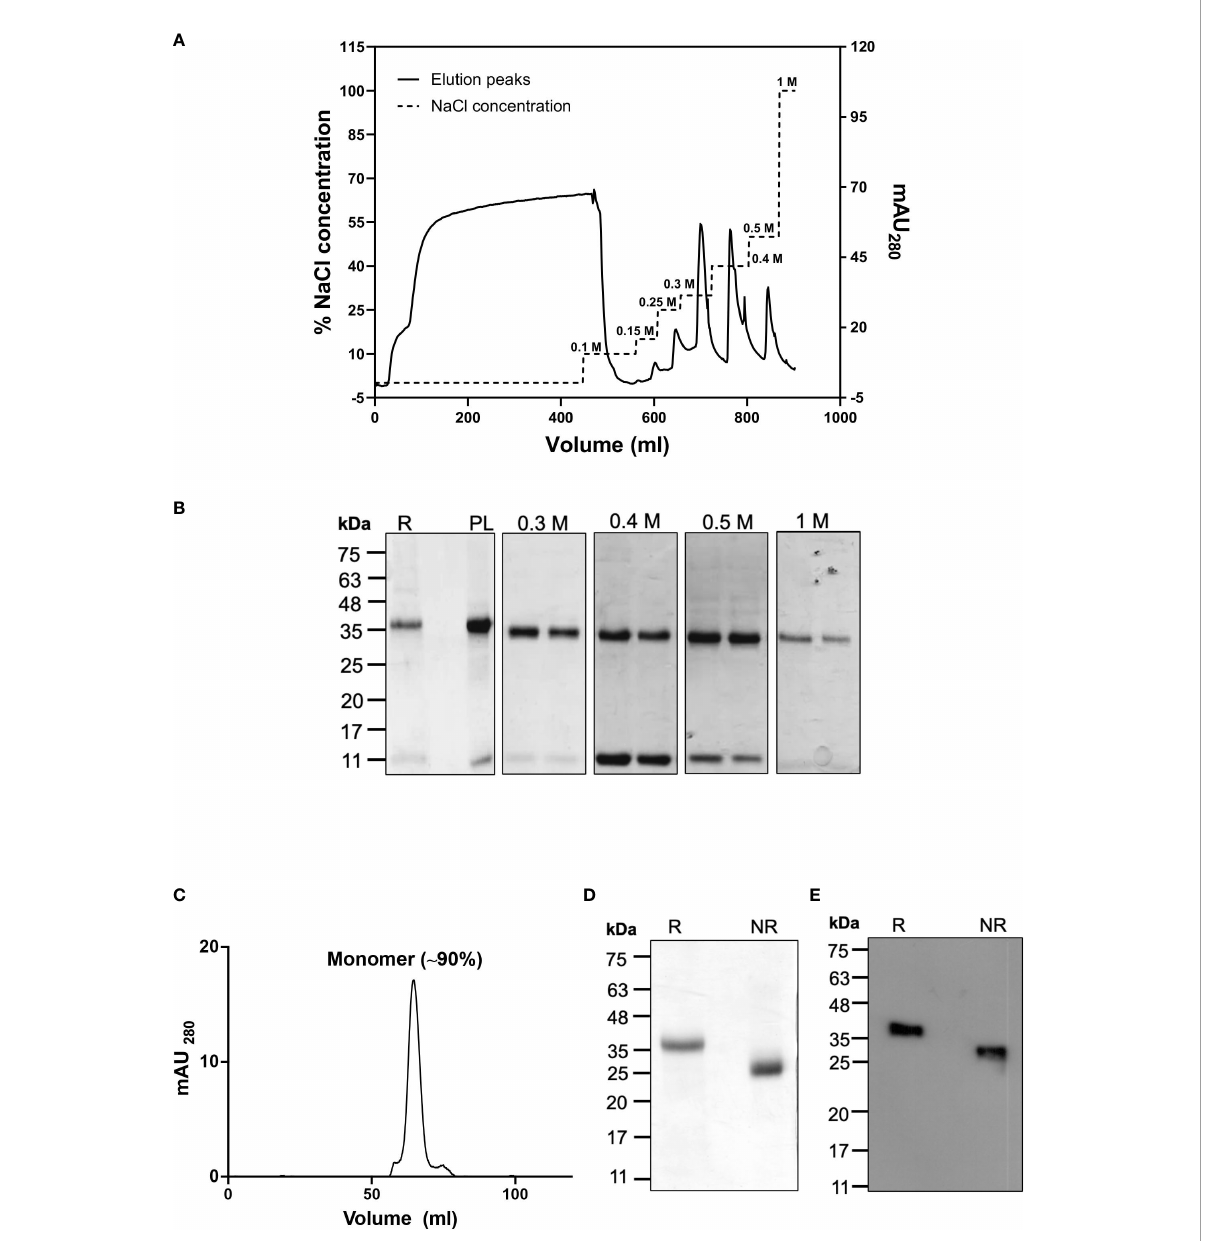
FIGURE 3 Puri fi cation of Tag-free CyRPA by Anion-Exchange Chromatography (A) After refolding, tag-free CyRPA was dialysed and subjected to ion exchange puri fi cation on an AKTA system using anion exchanger Q-sepharose beads. Column was equilibrated with a salt free Tris buffer, then dialyzed CyRPA was loaded onto the column, followed by washing (0.1 M NaCl) and elution (0.15, 0.25, 0.3, 0.4, 0.5 and 1 M NaCl). Solid line indicates elution peaks monitored at 280 nm and dashed lines show percent NaCl concentration used for CyRPA elution with 1 M representing the 100% concentration. (B) Expression of CyRPA after refolding (Refolded [R]), dialysis (dialysed or Preload [PL]) and elution was analyzed in reducing SDS-PAGE stained with Coomassie blue. The PL was loaded onto anion exchange column and after washing, elutes were collected and protein was observed at 0.3, 0.4, 0.5 and 1 M. No protein band was observed at 0.15 and 0.25 M NaCl concentration (data not shown) (C) Puri fi ed 0.3 M ion exchange elutes were analyzed by size exclusion chromatography that shows a major peak at ~63 ml that corresponds to the elution volume of a 40 kDa protein, thus, con fi rming that the 0.3 M ion-exchange fraction consisted of CyRPA monomer. The molecular weight of the eluted protein was determined using the calibration curve calculated by running protein molecular weight standards (Supplementary Figure S3D) (D, E) The monomeric CyRPA eluted at 0.3 M NaCl concentration in ion-exchange was analyzed under reducing and non-reducing conditions by Coomassie stained SDS-PAGE gel (D) and immunoblotting using anti-CyRPA rabbit polyclonal sera (E) . The resulting shift between reduced and non-reduced CyRPA in the Coomassie stained gel and immunoblot con fi rms that the recombinant protein was refolded successfully. This 0.3 M NaCl elute fraction was used as the fi nal protein in subsequent experiments. mAU 280 , milli-absorbance unit; R, Reducing; NR,